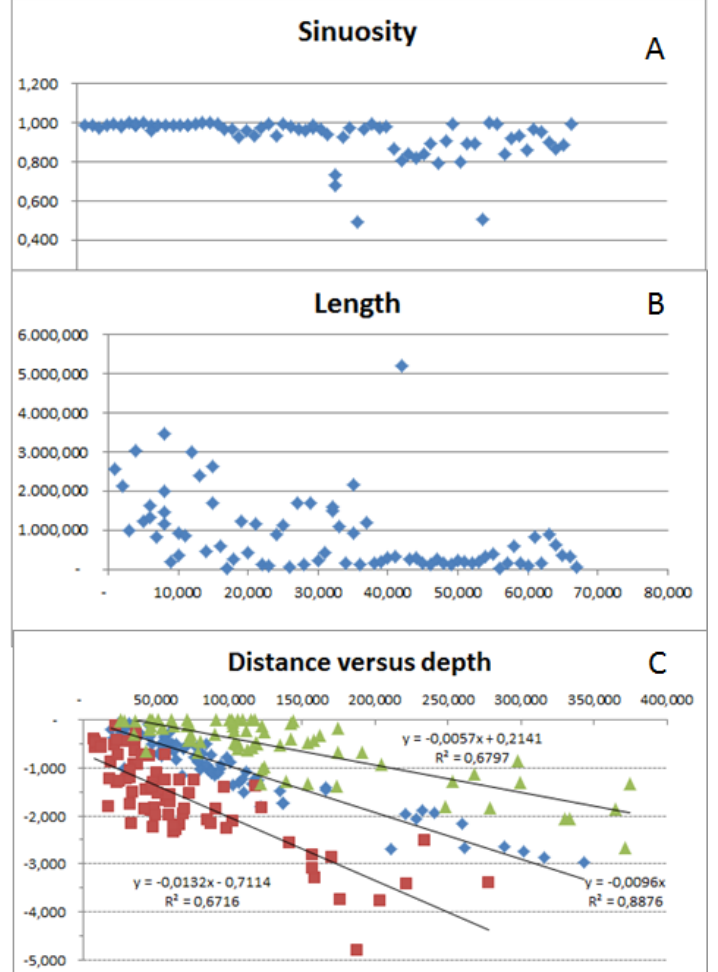
Figure 9. Sinuosity, length and distance versus depth of the sandbars system. ( A,B ) Sand bars from continuous long-linear sand bars evolve in a wavy crest moving southward; ( C ) correlation of distance versus depth of each sand bar’s crest from the shoreline.